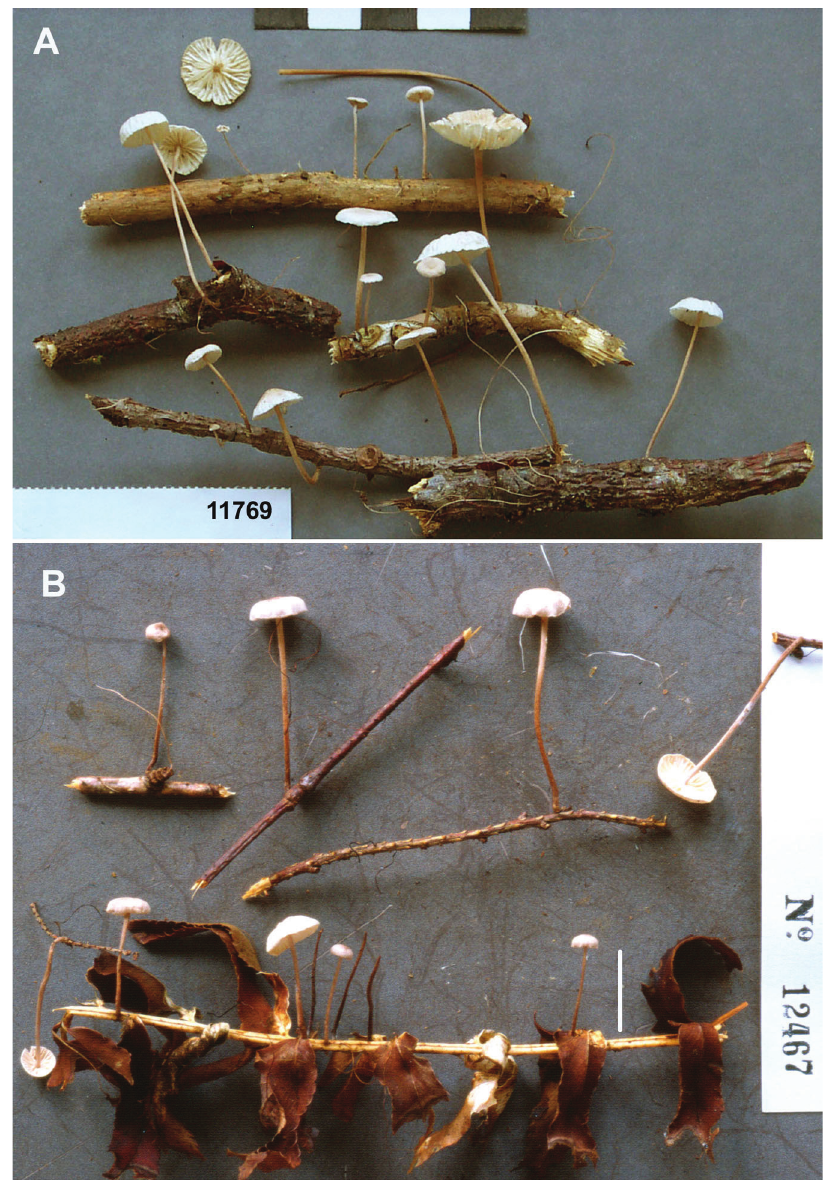
Figure 50. Mycetinis opacus . Basidiomata. A TFB 11769 (TENN-F-59880) B TFB 12467 (TENN-F-60541). Standard bars: A = ruler in millimeters. B = 20